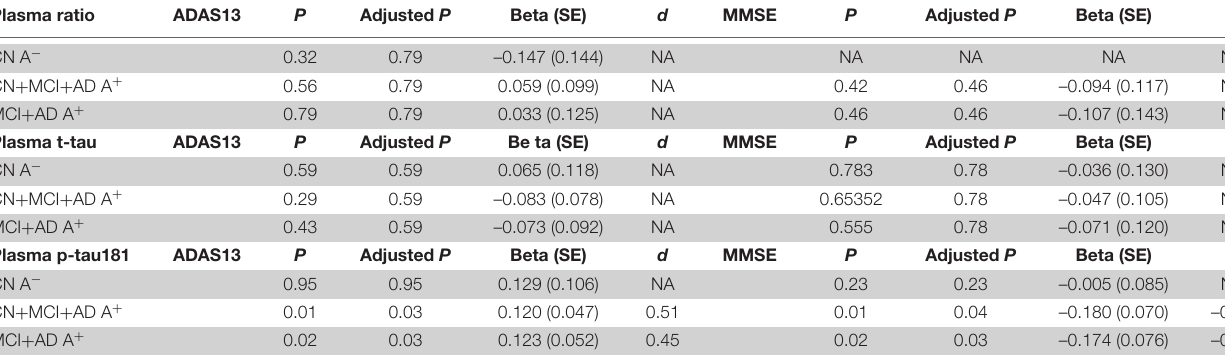
TABLE 7 | Statistical analysis of linear mixed-effect regression for plasma